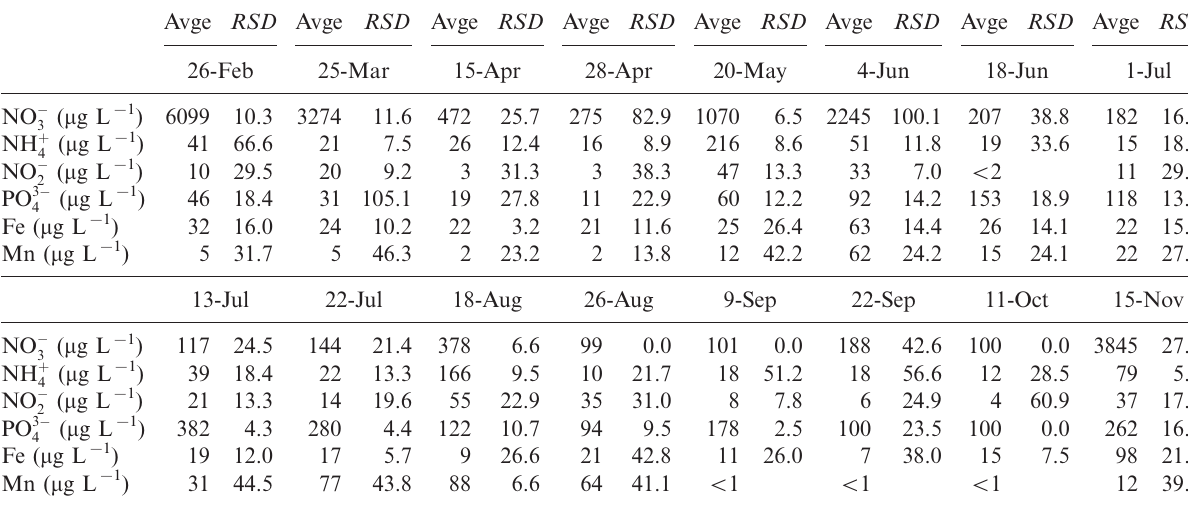
Table 2. Concentrations of nitrate, nitrite, ammonium, phosphate, iron and manganese (in m g L (cid:30) 1 ) in the overlying water from February to November 2010: average values for the 5 stations and relative standard deviations for these 5 results (RSD,